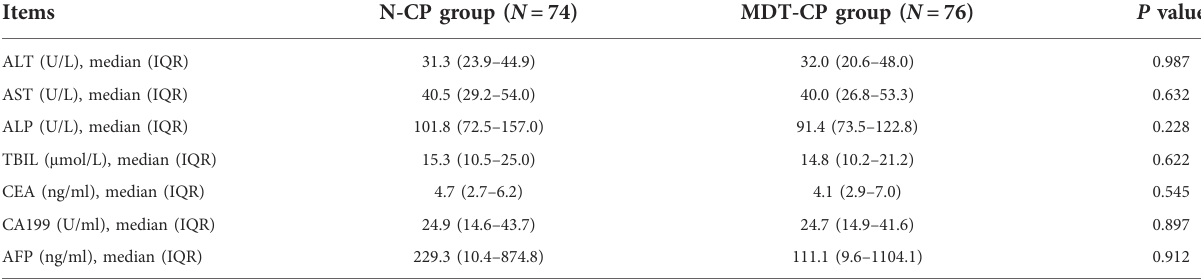
TABLE 2 Liver function indexes and tumor markers.